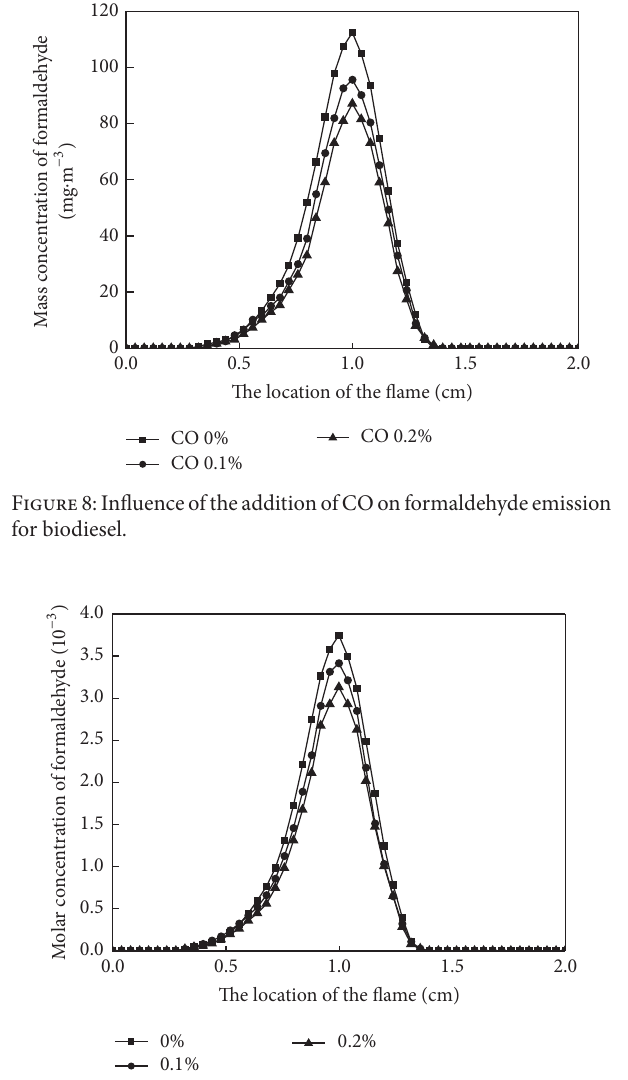
Figure 9: Influence of the addition of CH 4 on formaldehyde emission for